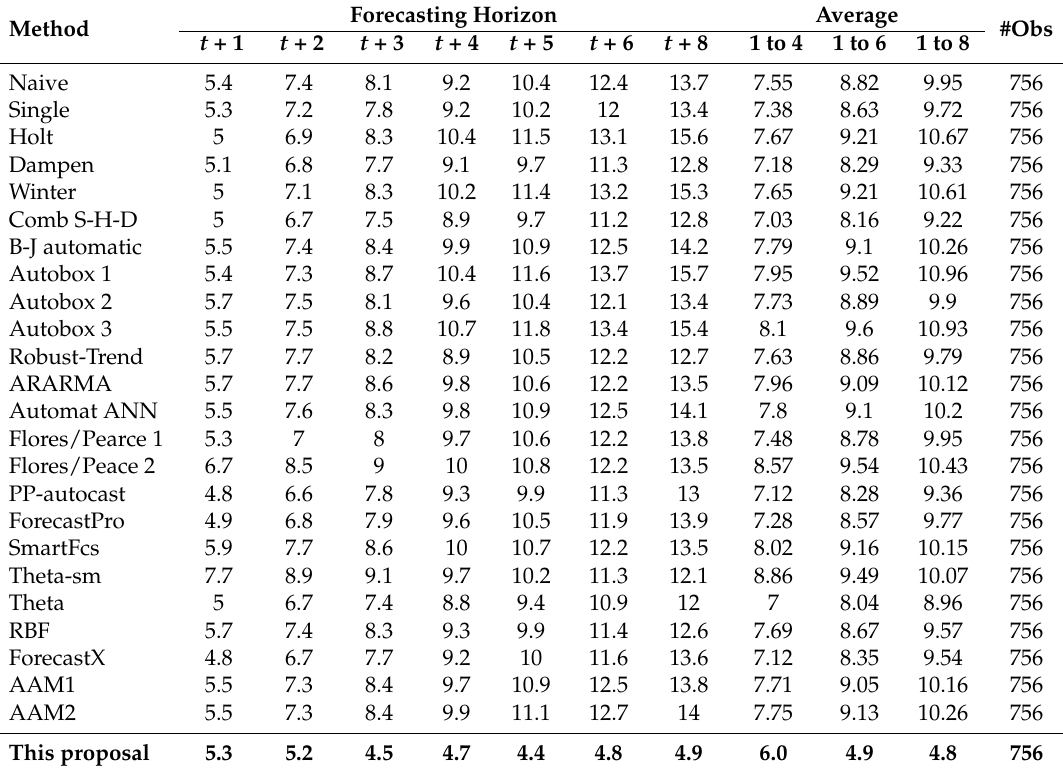
Table 6. SMAPE on M3-Competition for Quarterly